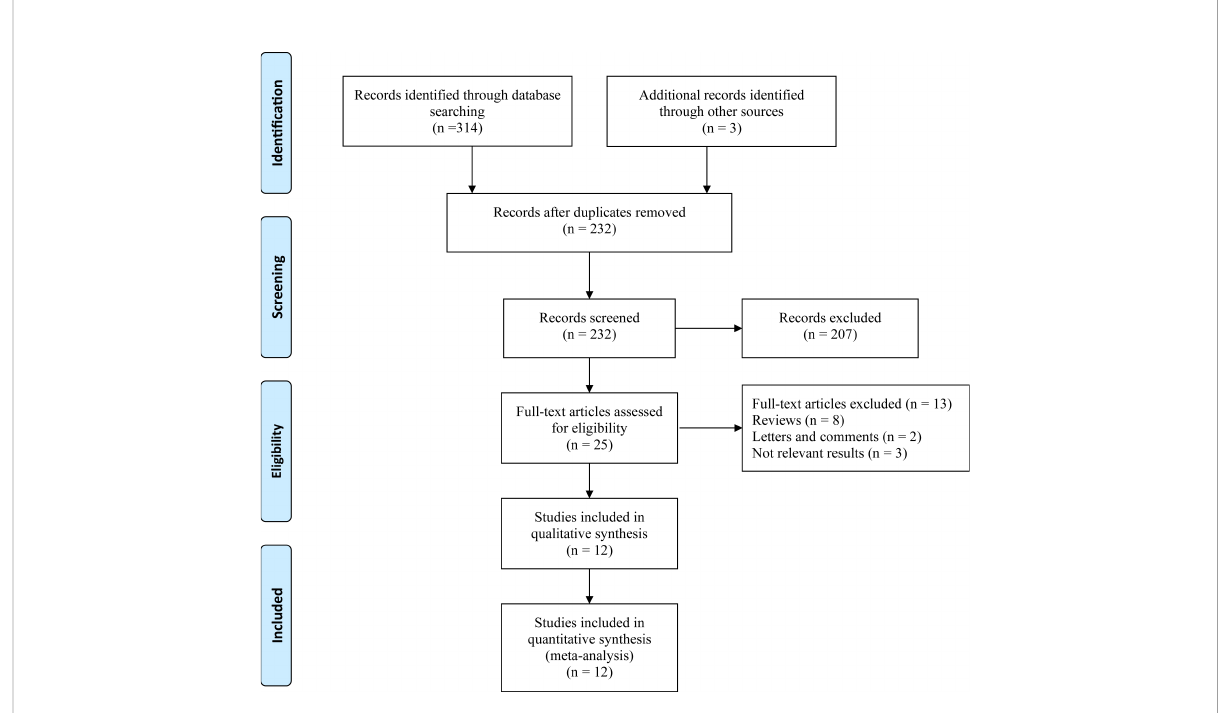
FIGURE 1 Flow diagram of studies selection